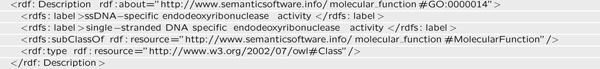
Molecular function in RDF For processing in OMM, the concepts are mapped from OBO-XML to RDF, here shown for the example of a molecular function, single-stranded DNA specific endodeoxyribonuclease activity (GO ID:0000014).